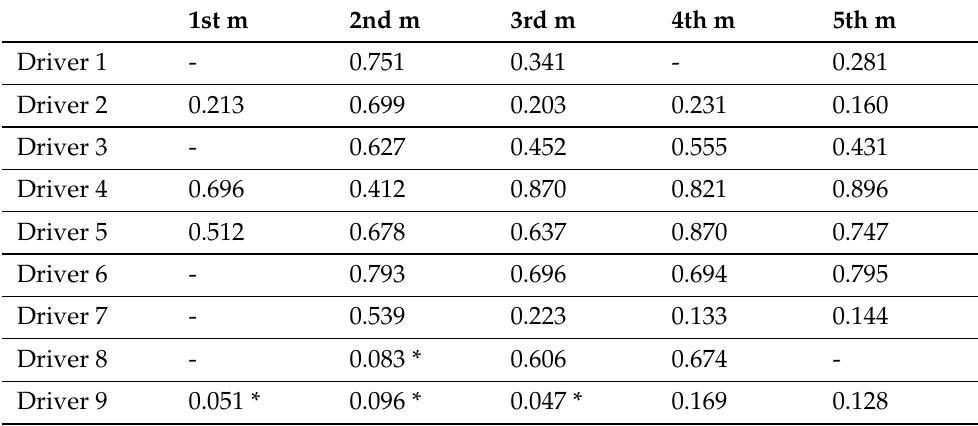
Table 4. Average p -value for speech signal with regard to time (minute) for Experiment 3 ( p -value below the threshold of 0.10 is marked using